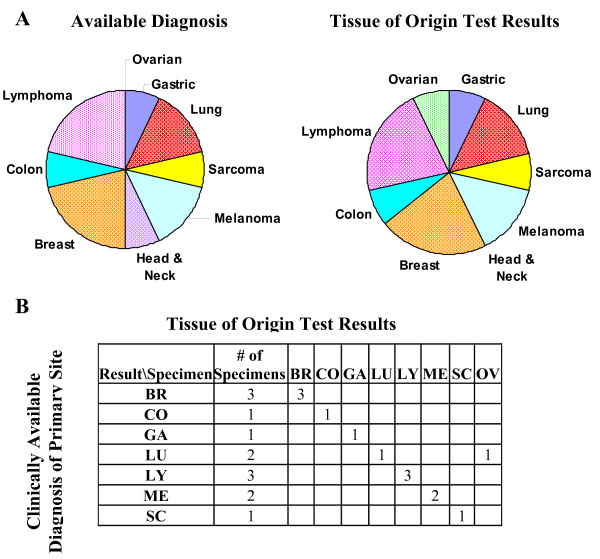
Distribution of the available diagnosis and the Tissue of Origin Test result by tissue type. Pie charts (A) and a confusion matrix (B) were used to compare the available diagnosis with the Tissue of Origin Test results. Among the cases that were on-panel, the Tissue of Origin Test had a 92.3% (12/13) agreement with the available diagnosis. The Tissue of Origin Test Result for the off-panel case of squamous cell carcinoma of the head and neck was lung. Abbreviations are BR = Breast, CO = Colon, GA = Gastric, LU = Lung, LY = Lymphoma, ME = Melanoma, SC = Sarcoma, OV = Ovarian.